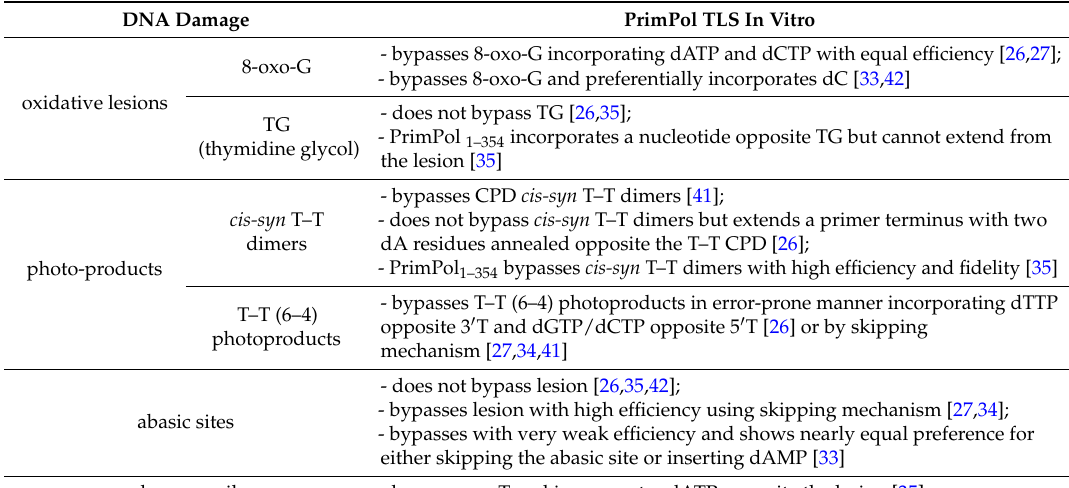
Table 1. The translesion synthesis (TLS) activity of human